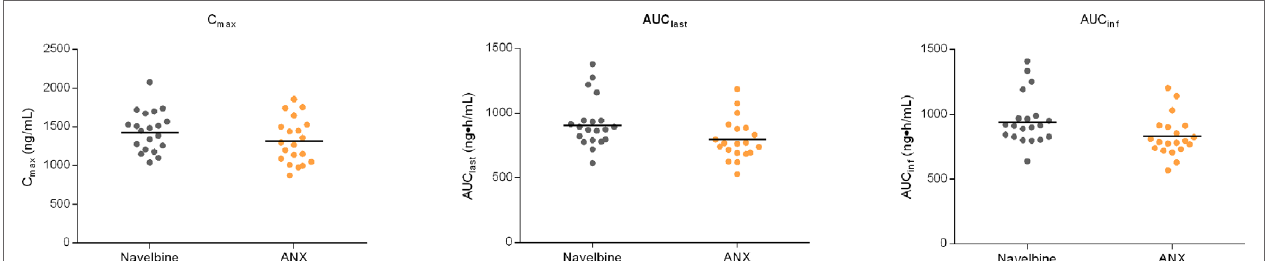
FIGURE 4 | Individual pharmacokinetic parameters.